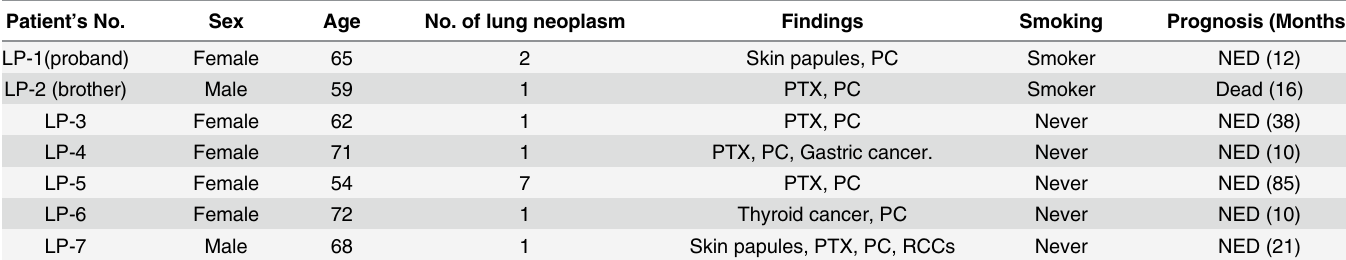
Table 1. Summary of clinical information. Patient ’ s No.